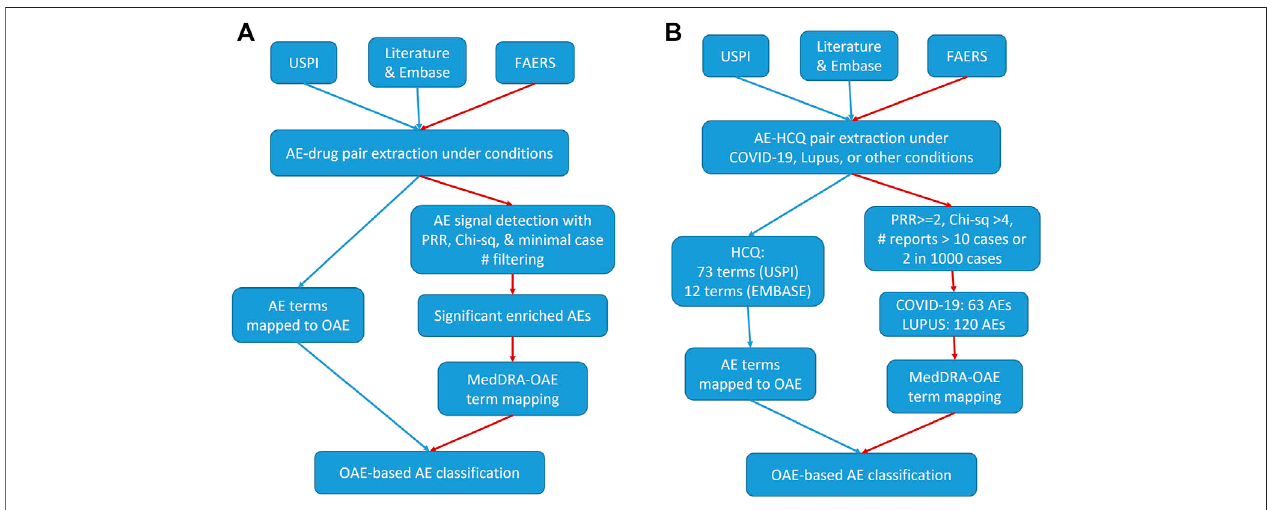
FIGURE1| Work fl owforourdrugAEanalysis. (A) Generalwork fl ow. (B) HCQspeci fi cwork fl ow.Theredpathspresentedwithrededgesrepresentthework fl owof FAERS-speci fi c drug AE analyses. USPI, United States Prescribing Information. FAERS, FDA Adverse Event Reporting System. AE, Adverse Event. PRR, Proportional Reporting Ratio. OAE, Ontology of Adverse Event. HCQ, hydroxychloroquine.